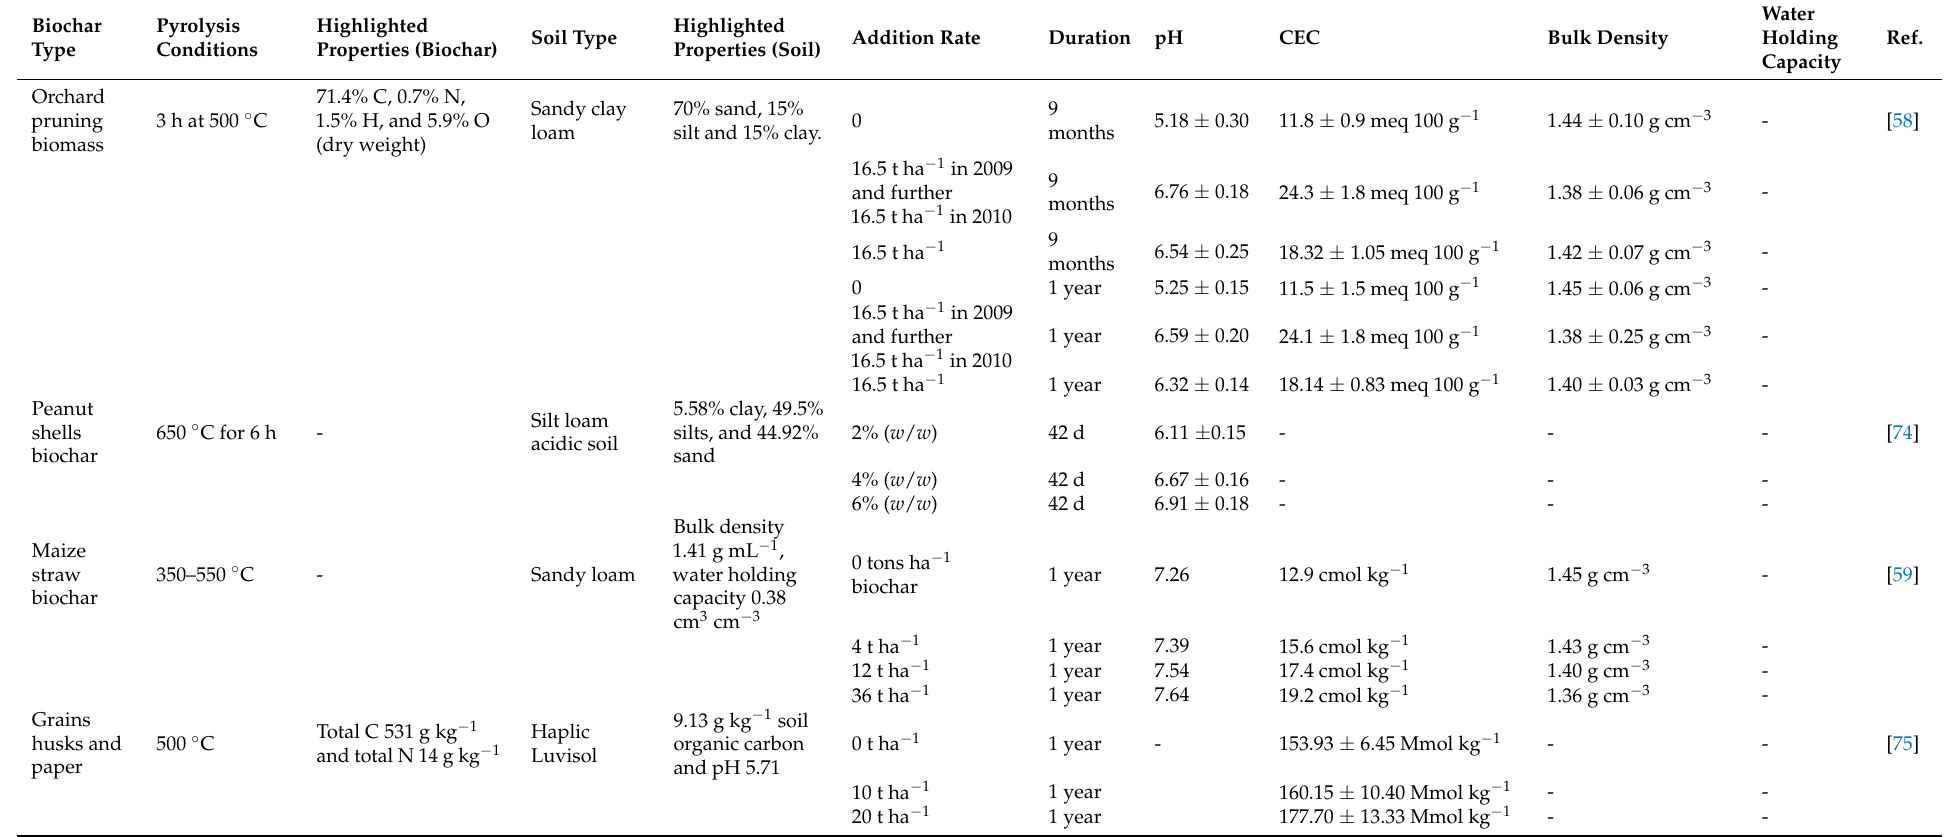
Table 1. The soil properties changes with biochar